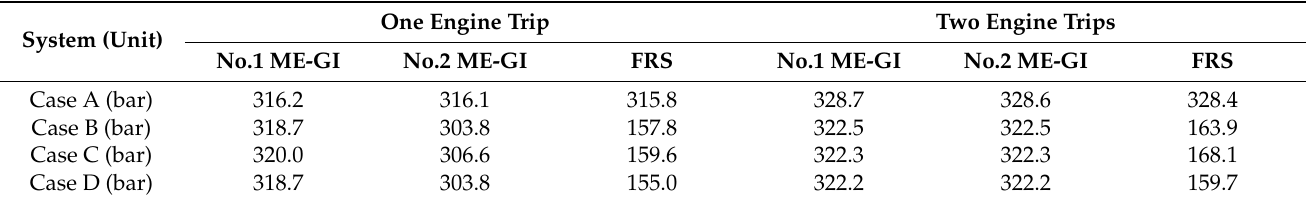
Table 6. Summary of dynamic simulation